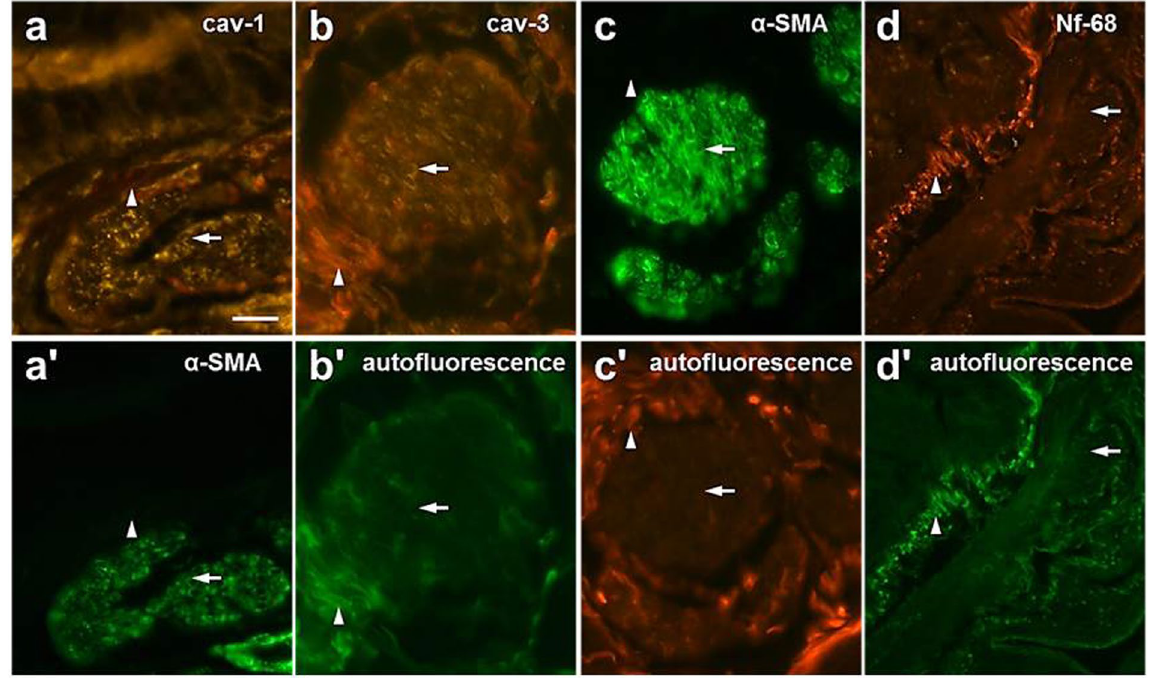
Figure 9. Immunofluorescence labelling for cav-3 in bronchial smooth muscle cells (SMC) of human lung. ( a -a’) Cav-1 and α -SMA-immunoreactivity were colocalized in bronchial SMC (arrow). ( b ) Cav-3- immunoreactivity was also in found in bronchial SMC as evident by the α -SMA-labelling (arrow) in the same region in adjacent sections ( c ). ( d ) Isotype control was done by incubation with the monoclonal Nf-68-antibody. (a’-d’) The autofluorescence of the epithelial basal membrane and of connective tissue fibers is indicated by arrowheads. Bar = 75 µ